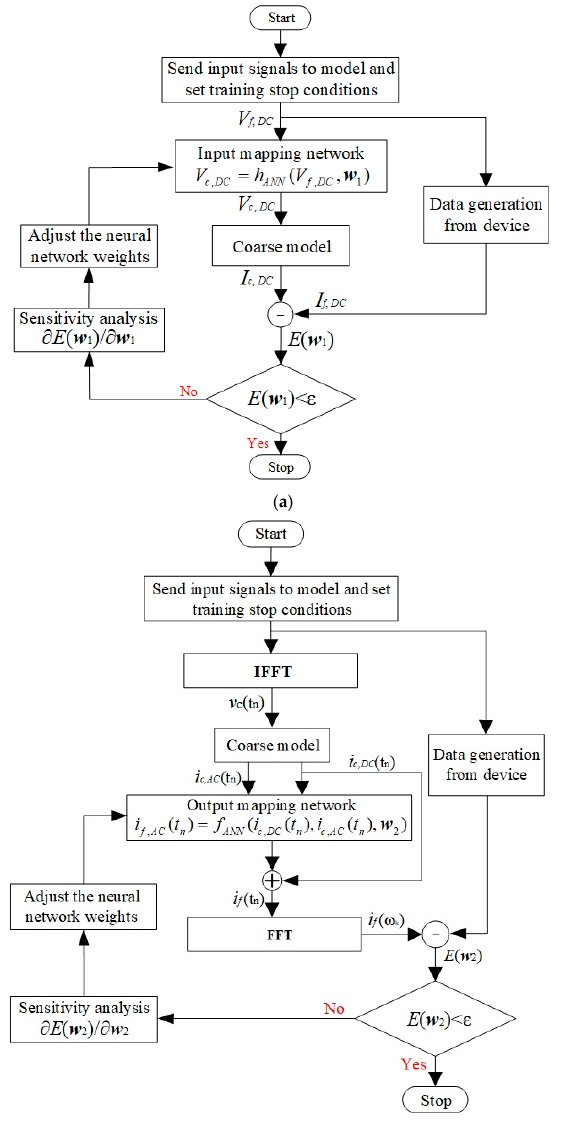
Figure 4. Advanced training process of the separated model. ( a ) DC model training. ( b ) AC model Figure 4. Advancedtrainingprocessoftheseparatedmodel. ( a )DCmodeltraining. ( b training.